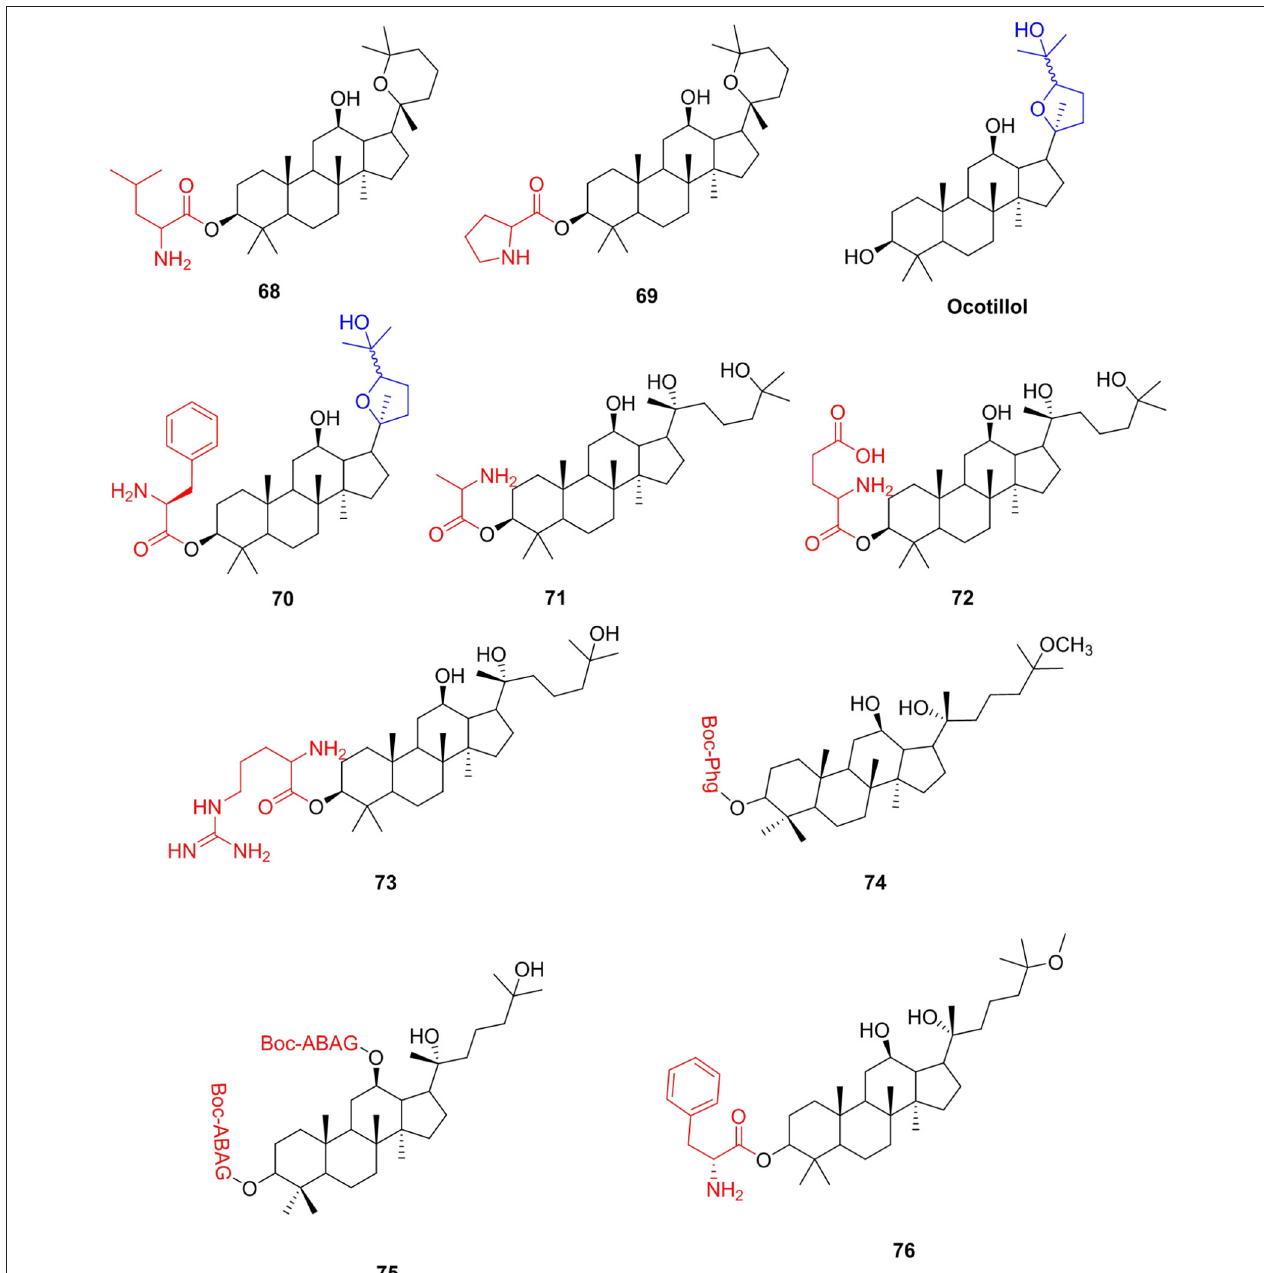
FIGURE 9 | Ginsenosides amino acid